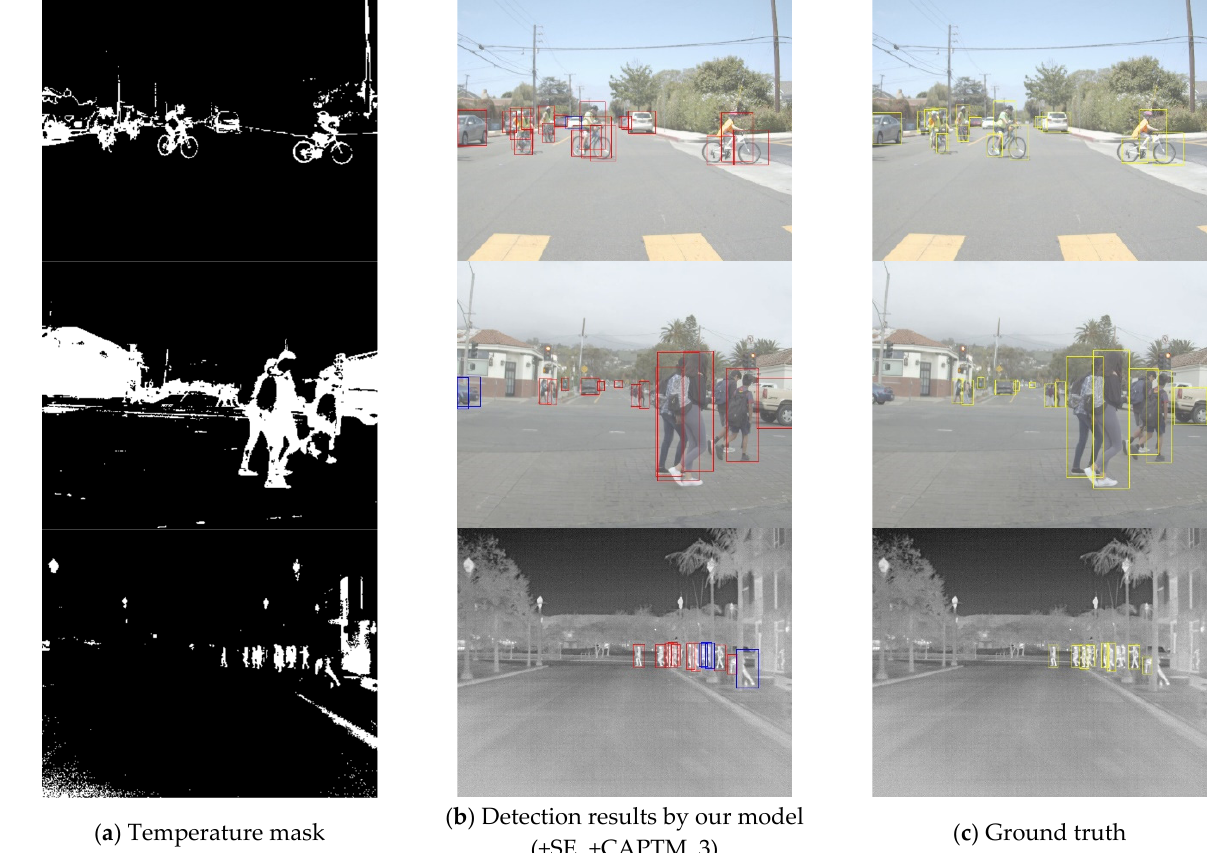
Figure 12. The detection results in ( b ) do not contain the noise (such as shadows, buildings, and street lights, etc.) in the background of ( a ). Even the street light in the third row, which has a very person-like silhouette, was not falsely detected. (Red, yellow, and blue respectively represent true-positive, false-negative, and false-positive results).